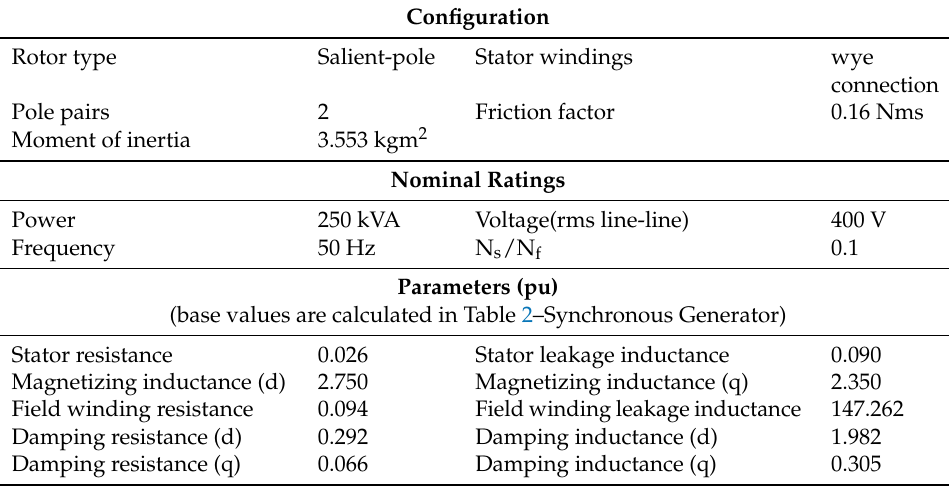
Table 3. Parameters of the SG in the microgrid.